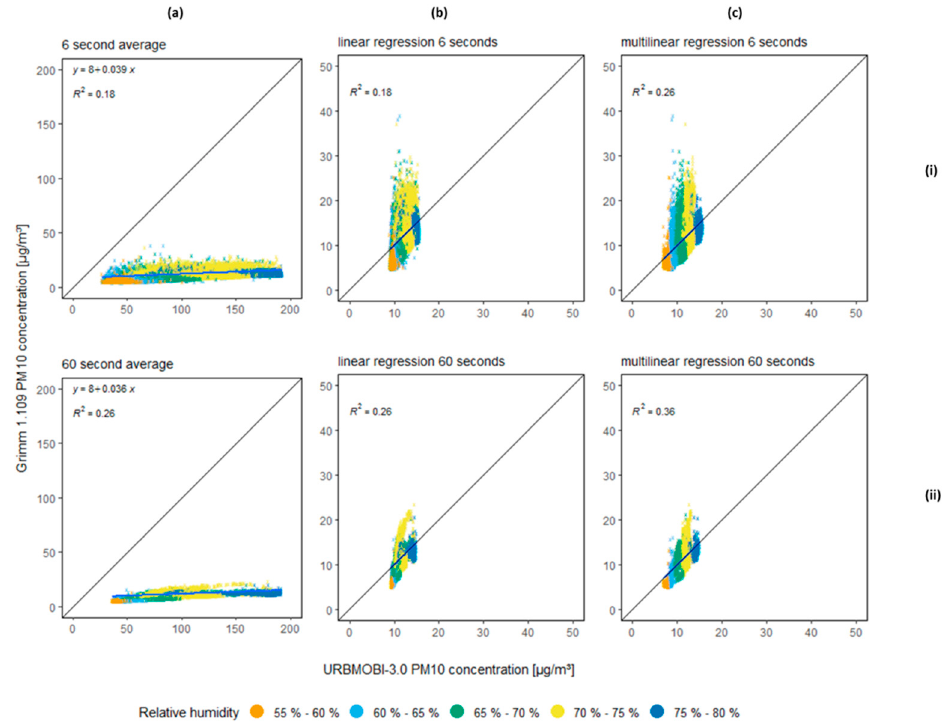
Figure 5. URBMOBI 3.0 (LCS) vs. Grimm 1.109 (reference device) PM10 comparison at Berlin-Adlershof; ( a ) scatter plot between the Grimm 1.109 raw data and URBMOBI 3.0 raw data with a time integral of 6 ( i ) and 60 ( ii ) seconds; ( b ) scatter plot between the Grimm 1. 109 raw data and URBMOBI 3.0 data corrected with linear regression with a time integral of 6 and 60 s ( c ) scatter plot between the Grimm 1.109 raw data and URBMOBI 3.0 data corrected with multi-linear regression, using temperature and RH as explaining variables, with a time integral of 6 and 60 s.